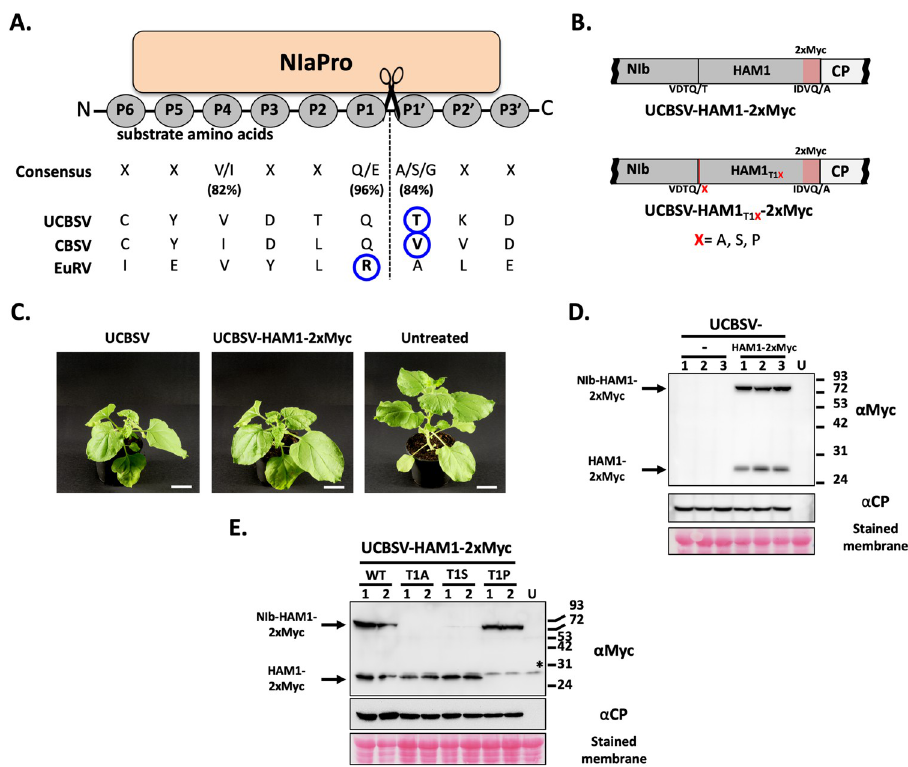
Fig 6. Suboptimal separation of NIb-HAM1 during UCBSV infection. (A) Schematic representation of a NIaPro cleavage site. Substrate residues at both sides of the scissile bond are labeled by following a previously proposed nomenclature [52]. The consensus sequence of NIaPro substrates, as well as those residues present at the NIb-HAM1 junction in UCBSV, CBSV and EuRV, are indicated. Percentages at which conserved amino acids were found at the indicated positions are shown (n = 1154) [42]. The non-conserved residue at the NIb-HAM1 cleavage site of each virus is surrounded by a blue circle. (B) Schematic representation of the NIb-to-CP genomic segment of viruses used in these experiments. Amino acids around the NIaPro cleavage sites are depicted. (C) Representative pictures of infected and non-treated N . benthamiana plants taken at 13 days post-inoculation. White bar = 4 cm. (D and E) Detection of Myc-tagged HAM1 and CP by immunoblot analysis in samples from upper non-inoculated leaves of N . benthamiana plants infected with the indicated viruses. The positions of prestained molecular mass markers (in kilodaltons) run in the same gels are indicated to the right. The black asterisk indicates the presence of a cross-reacting band in all the samples, including the untreated control. Blots stained with Ponceau red showing the large subunit of the ribulose- 1,5-bisphosphate carboxylase-oxygenase are included as a loading